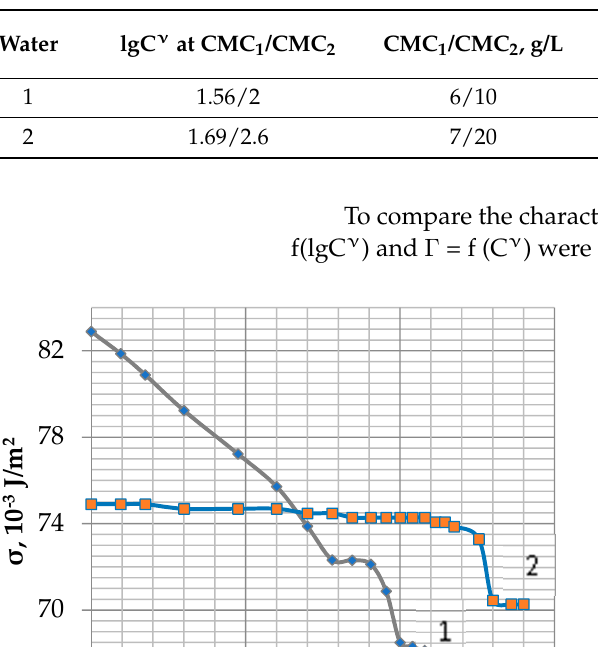
Table 22. Characteristics of plasticizer solutions.